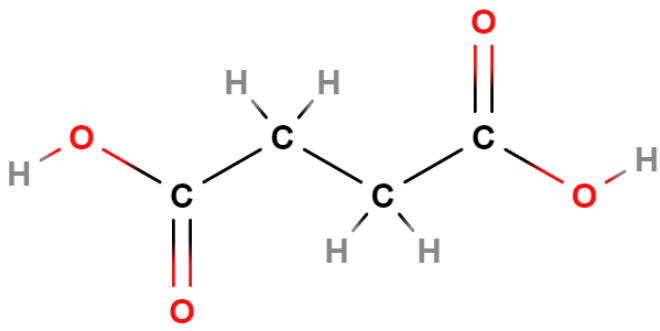
Figure 5. Structure of succinic acid (C 4 H 6 O 4 ).